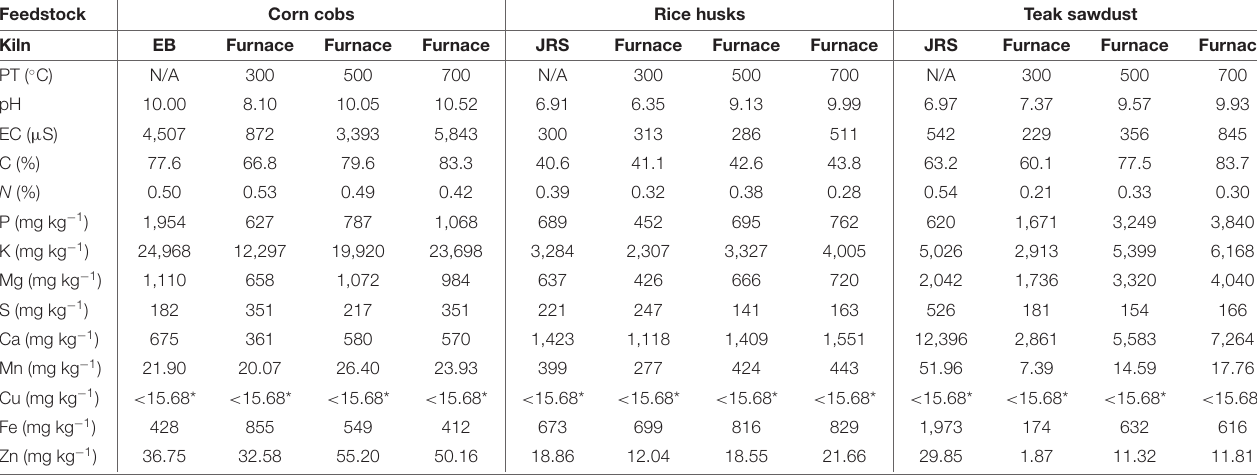
TABLE 2 | Chemical and physical properties of the biochars ( n =